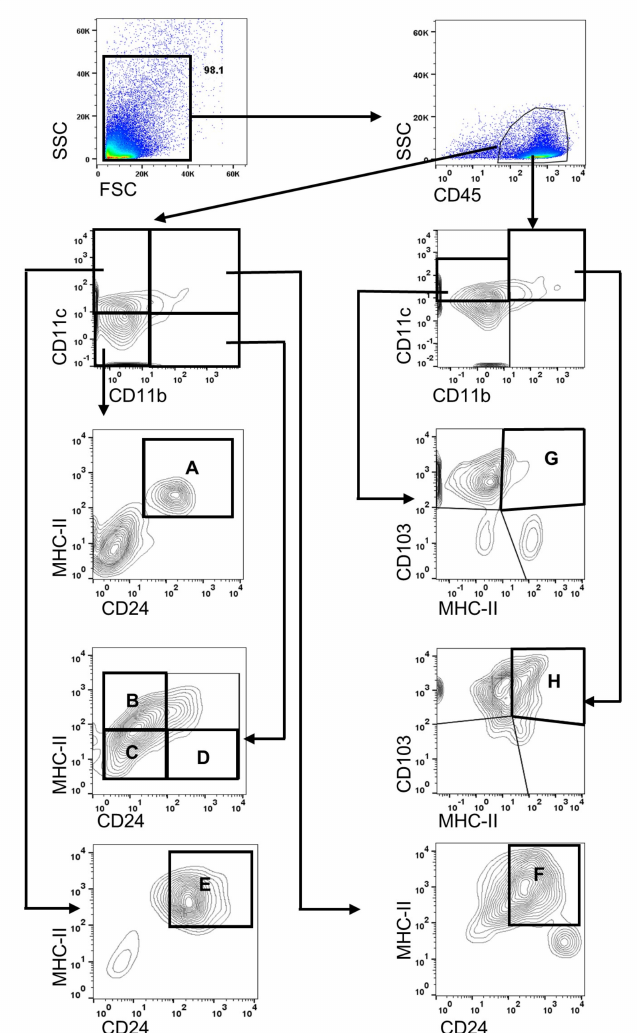
Figure 1. Gating strategy used to identify myeloid-cell and lymphoid-cell subsets. Following the exclusion of debris and cellular aggregates, forward-scatter and side-scatter gating were performed. The pan-hematopoietic marker CD45 was selected to distinguish immune cells from other corneolim- bal or lacrimal gland cells. A sequential gating strategy was used to identify populations expressing specific markers: ( A ) MHC-II hi B cells, ( B ) MHC-II hi macrophages, ( C ) MHC-II lo macrophages, ( D ) neutrophils and eosinophils, ( E ) CD11b - DC, ( F ) CD11b + DC, ( G ) CD103 + CD11b - DC, and ( H ) CD103 + CD11b + DC. DC, dendritic